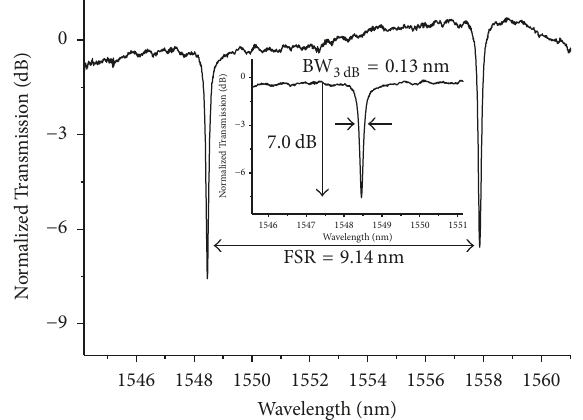
Figure 8: The transmission spectrum of the micro-nano Si/SiGe/Si double heterojunction micro-ring electro-optic modulation.